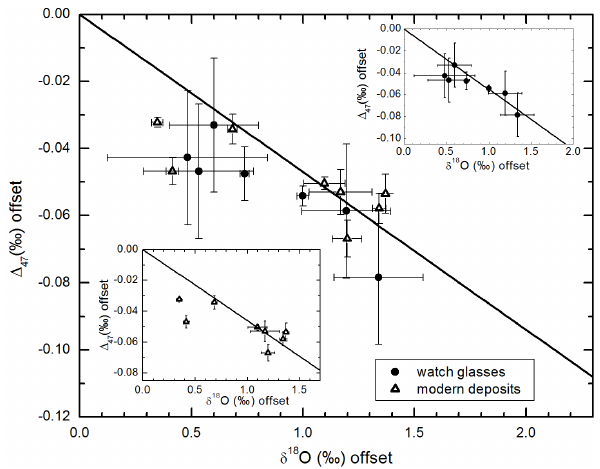
Fig. 1. 1 47 offset versus δ 18 O offset in different sets of mod- ern cave deposits. The thick line is a linear error-weighted fit through all modern calcites. It reflects the variable degree of ki- netic isotope fractionation and assumes that 1 47 and δ 18 O vary together in both CO 2 degassing and hydration/hydroxylation re- action. The insets depict separate fits of calcite precipitates on watch glasses from Bunker Cave (upper inset) and modern cal- cites from adjacent caves (lower inset) resulting in similar slopes (watch glasses: − 0.055 ± 0.002, modern deposits excluding watch glasses: − 0.046 ± 0.007, all modern calcite precipitates: − 0.047 ± 0.005). The origin is defined as the expected equilibrium for both δ 18 O and 1 47